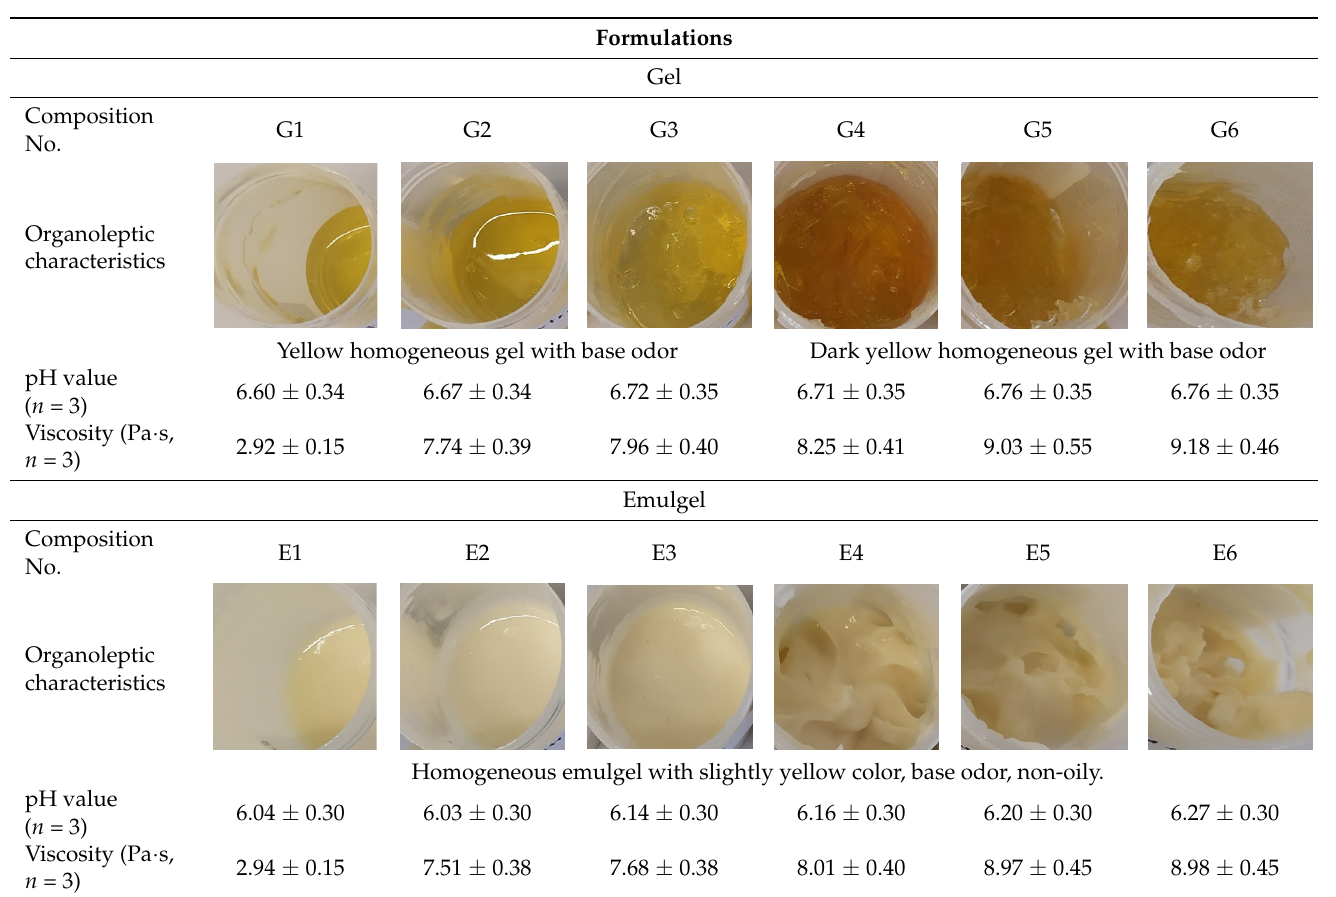
Table 2. Organoleptic characteristics and physicochemical parameters of gels and emulgels with 1% AE.